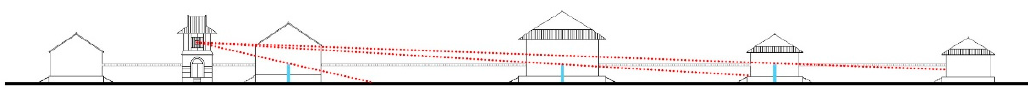
Figure 8. Diagram of sound rays.